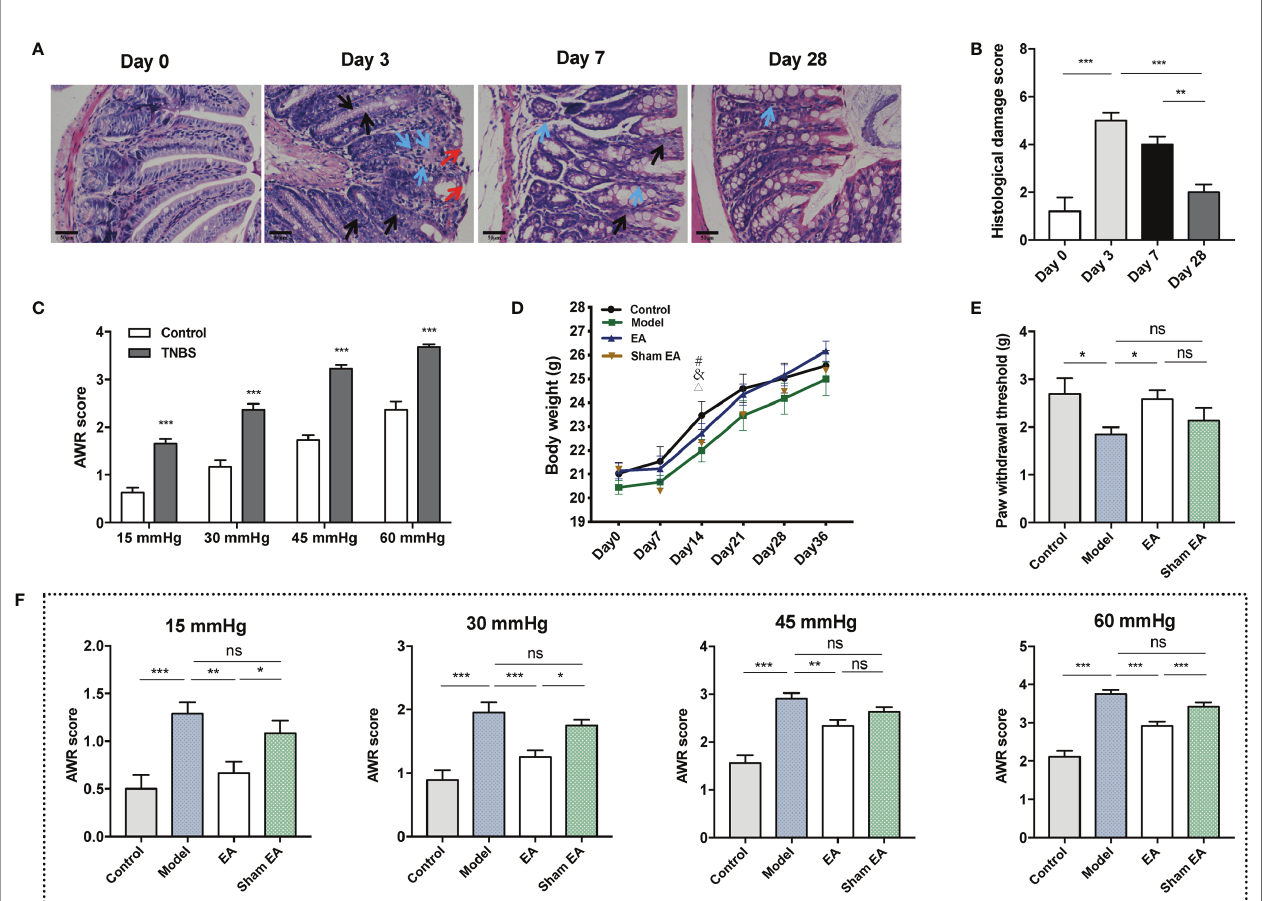
FIGURE 2 | Effect of EA on visceral and somatic hypersensitivity in PI-IBS model mice. (A) Representative HE images of the colon tissues in TNBS treated mice at day 0 (after saline intracolonic infusion), and 3, 7, 28 days after TNBS treatment (scale bar = 50 m m). Red arrowheads show destruction of mucosal architecture. Blue arrowheads represent cellular in fi ltration. Black arrowheads show goblet cell depletion. (B) Histological damage scoring of the colon tissues (n=5). (C) Abdominal withdrawal re fl ex scores indicating at stimulation pressures of 15, 30, 45, and 60 mmHg in control (n = 10) and TNBS treated mice (n = 30). (D) Body weight of mice during the experiment I. (E) Hind paw withdrawal threshold evaluated after the treatment of electroacupuncture/sham electroacupuncture (n = 6 per group). (F) Abdominal withdrawal re fl ex (AWR) scores at stimulation pressures of 15, 30, 45, and 60 mmHg in each group (n = 6 per group). Data are presented as mean ± SEM; (B, E , and F) : One-way ANOVA with LSD multiple comparisons test; (C) : two-tailed Mann – Whitney test; (D) : generalized estimating equations, # : model versus control, & : EA versus control, △ : sham EA versus control, P < 0.05; * P <0.05, ** P < 0.01, *** P < 0.001, ns P